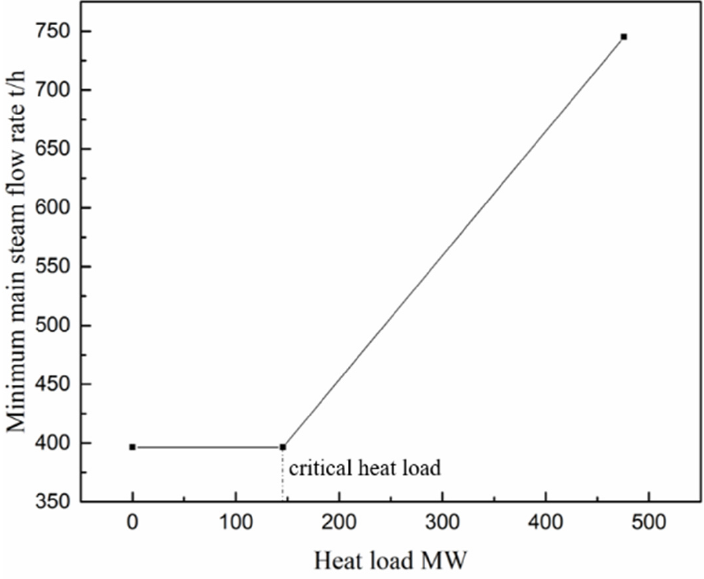
Figure 6. Variation of the minimum main steam flow with the heat extraction steam flow.